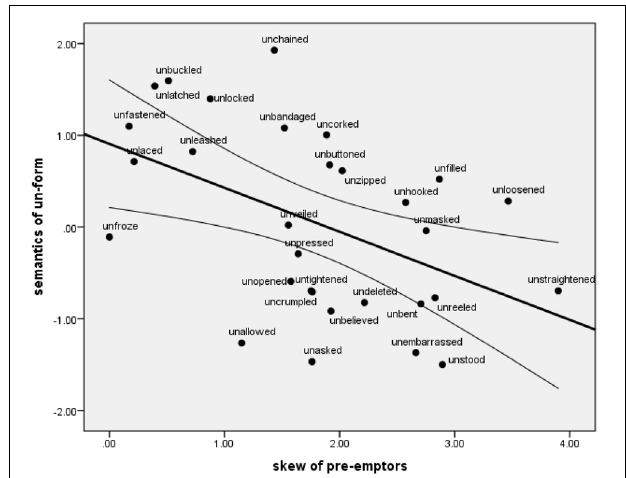
FIGURE 4 | Correlation between the semantic rating of the verb and the skew of its pre-emptors, r ( 30 ) = − 0 . 478, p < 0 . 01, line of best fit displayed with 95% confidence